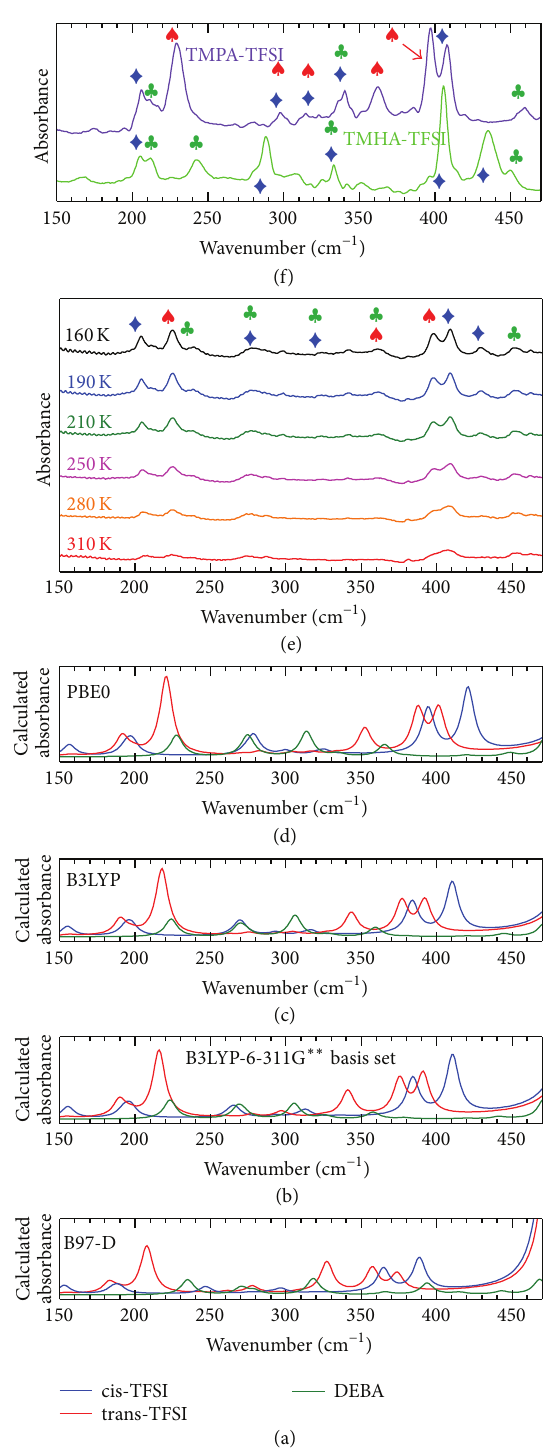
Figure 3: Measured infrared absorption of DEBA-TFSI as a function of temperature (panel (e), curves are stacked for clarity). The symbols refer to the attribution of the lines to trans-TFSI (red), cis-TFSI (blue), and cation (green) vibrations. For comparison purpose, the absorptions of TMPA-TFSI and TMHA-TFSI measured at 160 K are shown in panel (f) with the attribution of lines (same symbols used for DEBA-TFSI) [17]. In panels (a)–(d) absorptions of single ions in the frequency range between 150 and 460 cm −1 calculated with the various combinations of theories and basis sets are reported. No scaling factor was